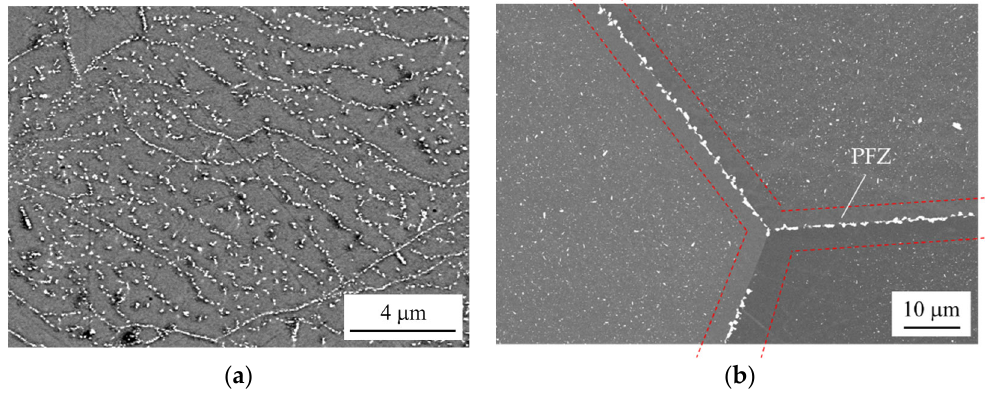
Figure 7. Microstructures of rolled 17Cr1_1 material after annealing at 650 °C: ( a ) at 3 h: intragranular Laves phase precipitates, aligned at sub ‐ grain boundaries and dislocations, ( b ) at 3500 h: intragranular Laves phase precipitates, particle ‐ covered high ‐ angle grain boundaries, along with the formation of particle ‐ free zones (PFZ), and a recovered sub ‐ grain structure.